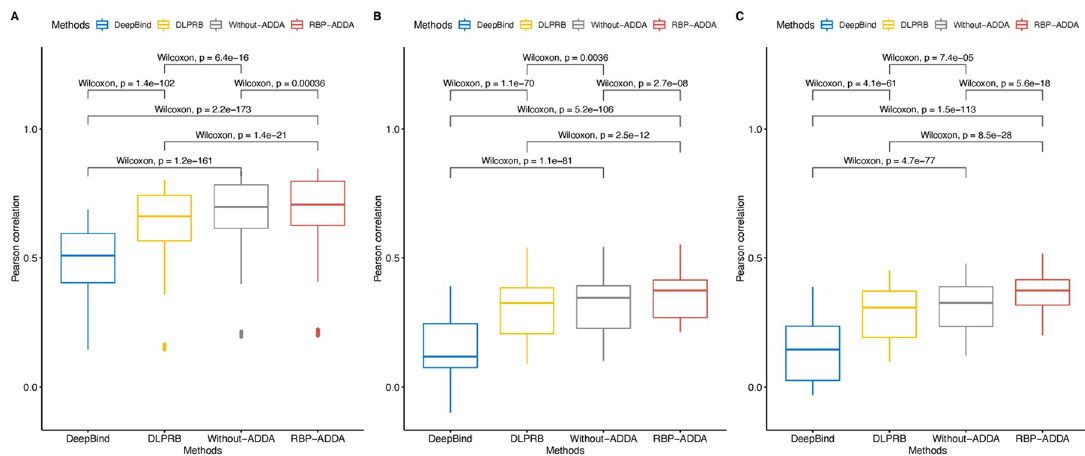
Fig 2. Comparison of performances between RBP-ADDA and other methods. (A) Comparison on 25 in vitro RNAcompete datasets; (B) Comparison on 19 eCLIP datasets from HepG2 cell line; (C) Comparison on 19 eCLIP datasets from K562 cell line. P-values are computed using unpaired Wilcoxon rank sum one-tailed test with